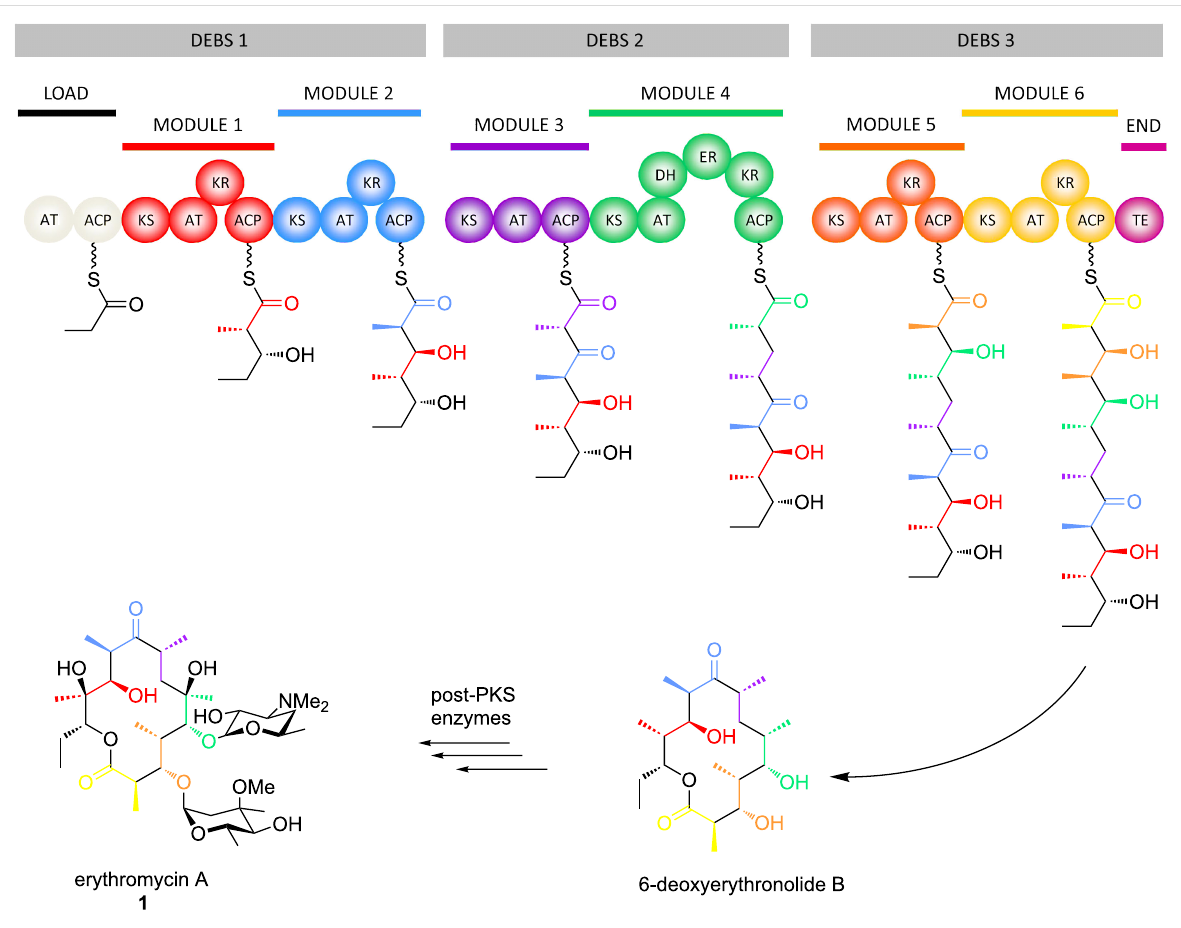
Figure 3: Schematic of the biosynthetic pathway leading to erythromycin A ( 1 ) in the bacterium Saccharopolyspora erythraea . The first stage of bio- synthesis occurs on a modular polyketide synthase (PKS) incorporating three gigantic multienzyme polypeptides, DEBS 1, 2 and 3. Each of these subunits contains two chain extension modules, while DEBS 1 additionally incorporates a loading module to initiate the biosynthesis, and DEBS 3, a termination module, consisting of a thioesterase (TE) domain. Each of the chain extension modules includes three essential domains (ketosynthase (KS), acyl transferase (AT) and acyl carrier protein (ACP)), and a variable complement of processing activities (ketoreductase (KR), dehydratase (DH) and enoyl reductase (ER)). The number and character of the variable domains correlates precisely with the structure of the resulting intermediates (the building block added at each stage is color-coded to match the module responsible). Following release of the chain from the PKS, the first free intermediate, 6-deoxyerythronolide B, is further modified by a series of post-PKS enzymes to yield the final, bioactive